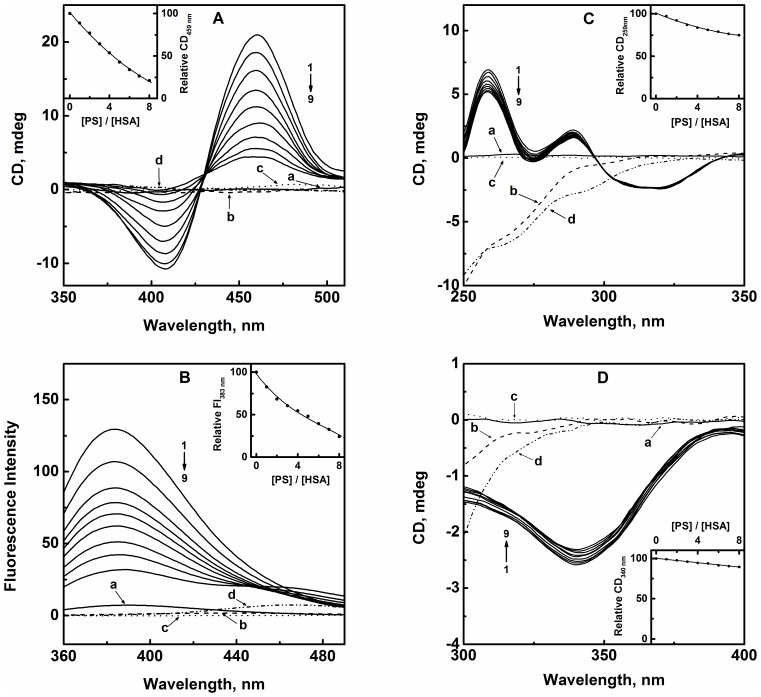
Displacement of site marker ligands bound to HSA in presence of increasing PS concentrations.(A) CD spectra of BR–HSA complex (10 µM each) in the absence (1) and presence (2–9) of increasing PS concentrations (10–80 µM with 10 µM intervals). Spectra marked as ‘a’, ‘b’, ‘c’ and ‘d’ refer to 10 µM BR, 10 µM HSA, 50 µM PS and PS–HSA (5∶1) complex, respectively. Inset shows the decrease in the relative CD value at 459 nm (CD459 nm) with increasing PS/HSA molar ratios. (B) Fluorescence spectra of WFN–HSA complex (3 µM each) in the absence (1) and presence (2–9) of increasing PS concentrations (3–24 µM with 3 µM intervals). Spectra labeled as ‘a’, ‘b’, ‘c’ and ‘d’ refer to 3 µM WFN, 3 µM HSA, 15 µM PS and PS–HSA (5∶1) complex, respectively. Inset shows the decrease in the relative fluorescence intensity at 383 nm (FI383 nm) with increasing PS/HSA molar ratios. (C) CD spectra of DZM–HSA complex (20 µM DZM +10 µM HSA) in the absence (1) and presence (2–9) of increasing PS concentrations (10–80 µM with 10 µM intervals). Spectra marked as ‘a’, ‘b’, ‘c’ and ‘d’ represent 20 µM DZM, 10 µM HSA, 50 µM PS and PS–HSA (5∶1) complex, respectively. Inset shows the change in the relative CD value at 259 nm (CD259 nm) with increasing PS/HSA molar ratios. (D) CD spectra of KTN–HSA complex (20 µM KTN +10 µM HSA) in the absence (1) and presence (2–9) of increasing PS concentrations (10–80 µM with 10 µM intervals). Spectra labeled as ‘a’, ‘b’, ‘c’ and ‘d’ refer to 20 µM KTN, 10 µM HSA, 50 µM PS and PS–HSA (5∶1) complex, respectively. Inset shows the change in the relative CD value at 340 nm (CD340 nm) with increasing PS/HSA molar ratios.